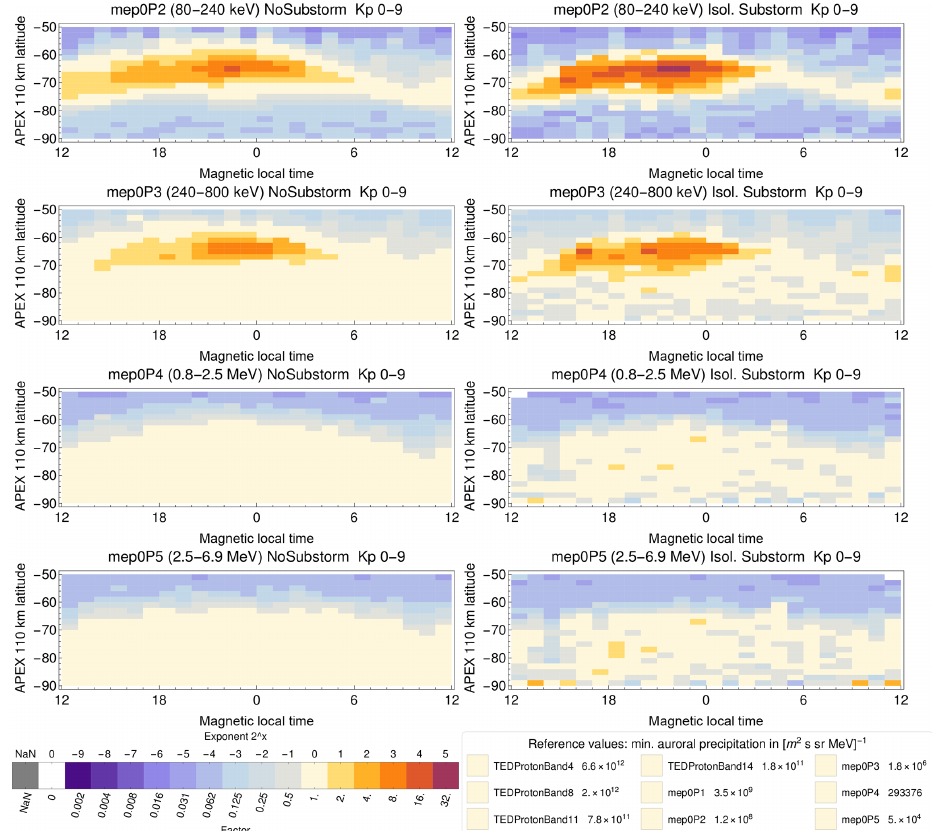
Figure 4. Proton flux in various channels at high latitudes in the Southern Hemisphere.